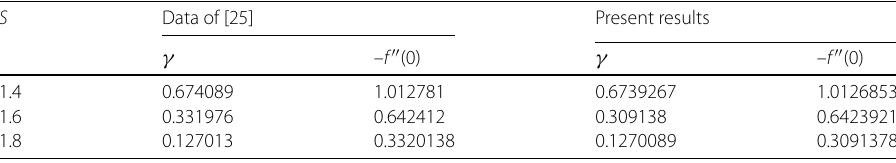
Figure 1 The velocity distribution with different values of